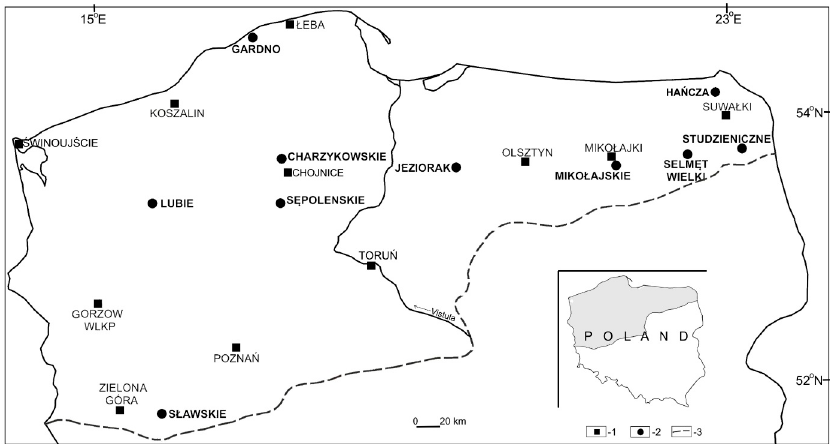
Figure 1. Location of study objects: 1—meteorological stations, 2—lakes, 3 (dashed line)—maximum range of the last glaciation.